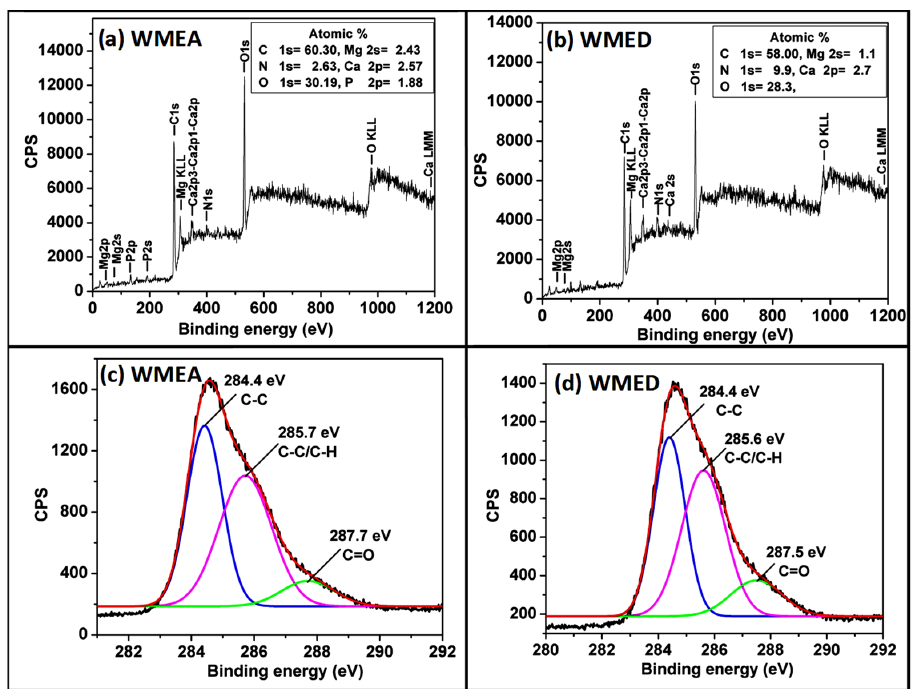
Figure 4. Full range XPS analysis of watermelon-CQDs prepared by adding ( a ) ethanol amine; ( b ) ethylene diamine; high-resolution XPS spectra of the C1s region of watermelon-CQDs synthesized by adding ( c ) ethanol amine; ( d ) ethylene diamine.